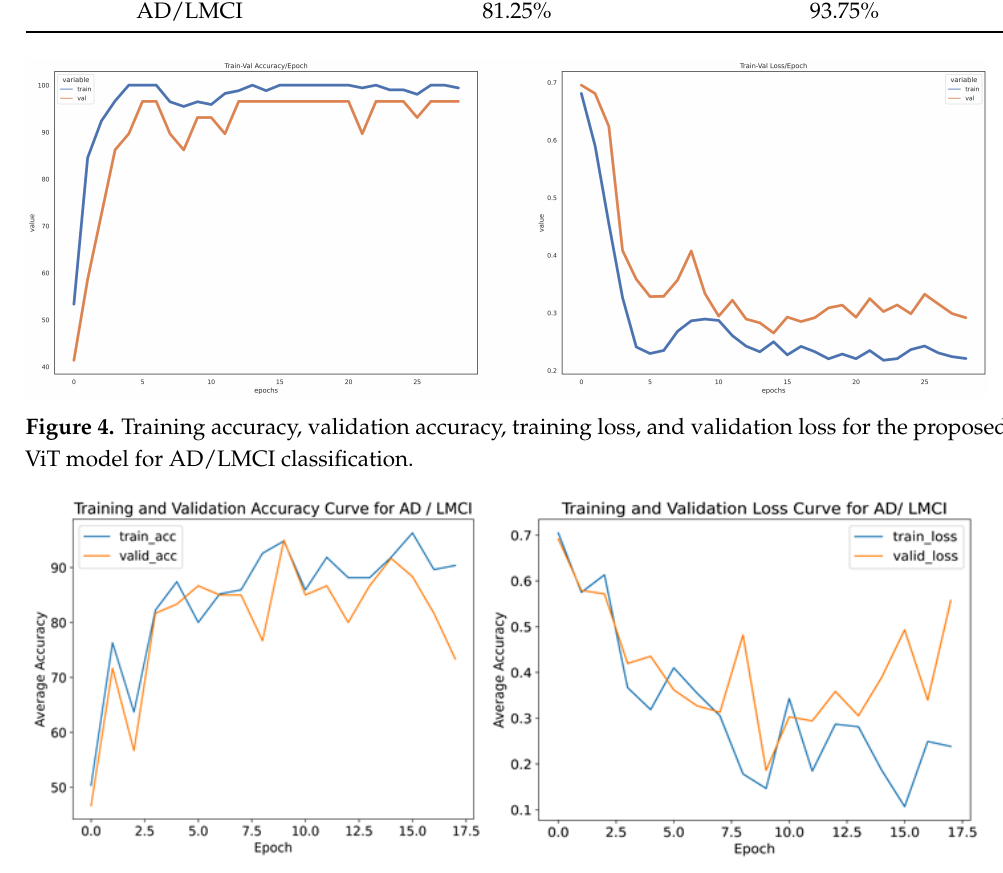
Figure 5. Training accuracy, validation accuracy, training loss, and validation loss for pre-trained ResNet18 model for